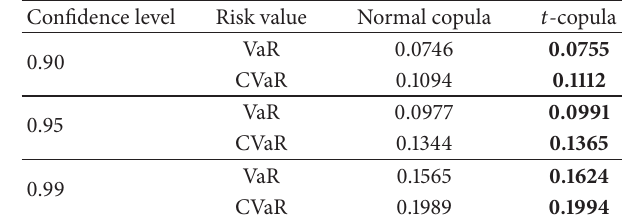
Table 7: Portfolio risk under equally weighted natural gas